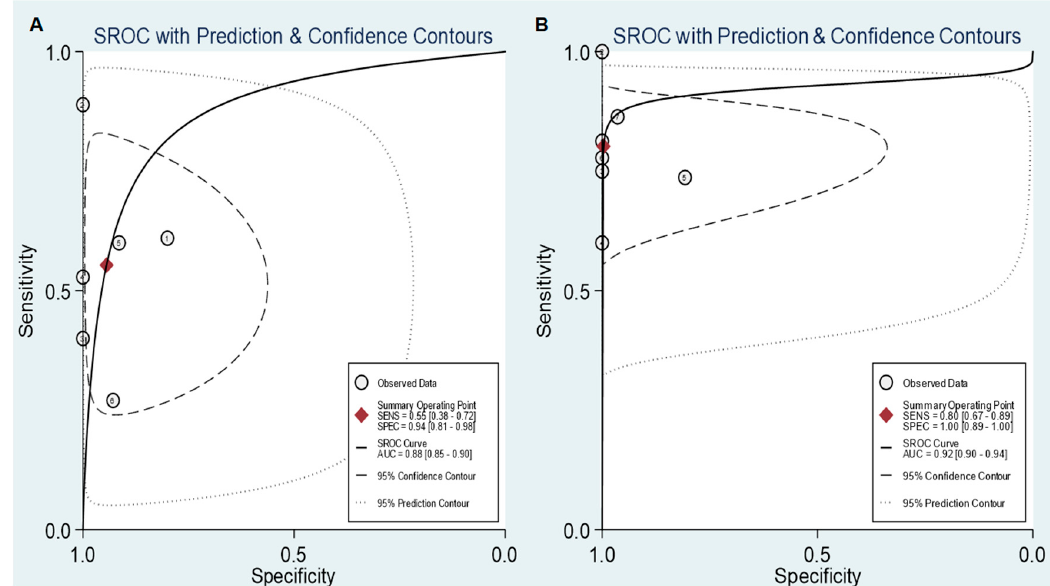
Figure 4. Summarized receiver operating characteristic (SROC) curves of FDG PET/CT and PET/MRI for detecting lymph node metastasis ( A ) and distant metastasis ( B ). Each circle represents the sensitivity and specificity of each of the included studies. The diamond is the summary point for the average sensitivity and specificity estimates. The ellipse with the dashed line is the 95% confidence region, and the ellipse with the dotted line is the 95% prediction region.